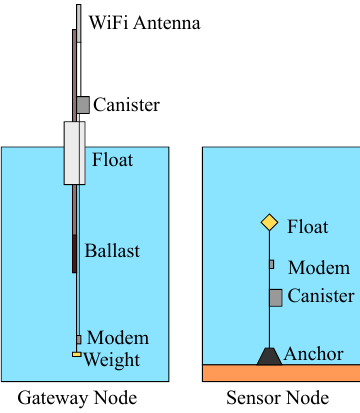
Figure 20. The moorings for the gateway node and the sensor node showing the use of weights and floats to maintain modem